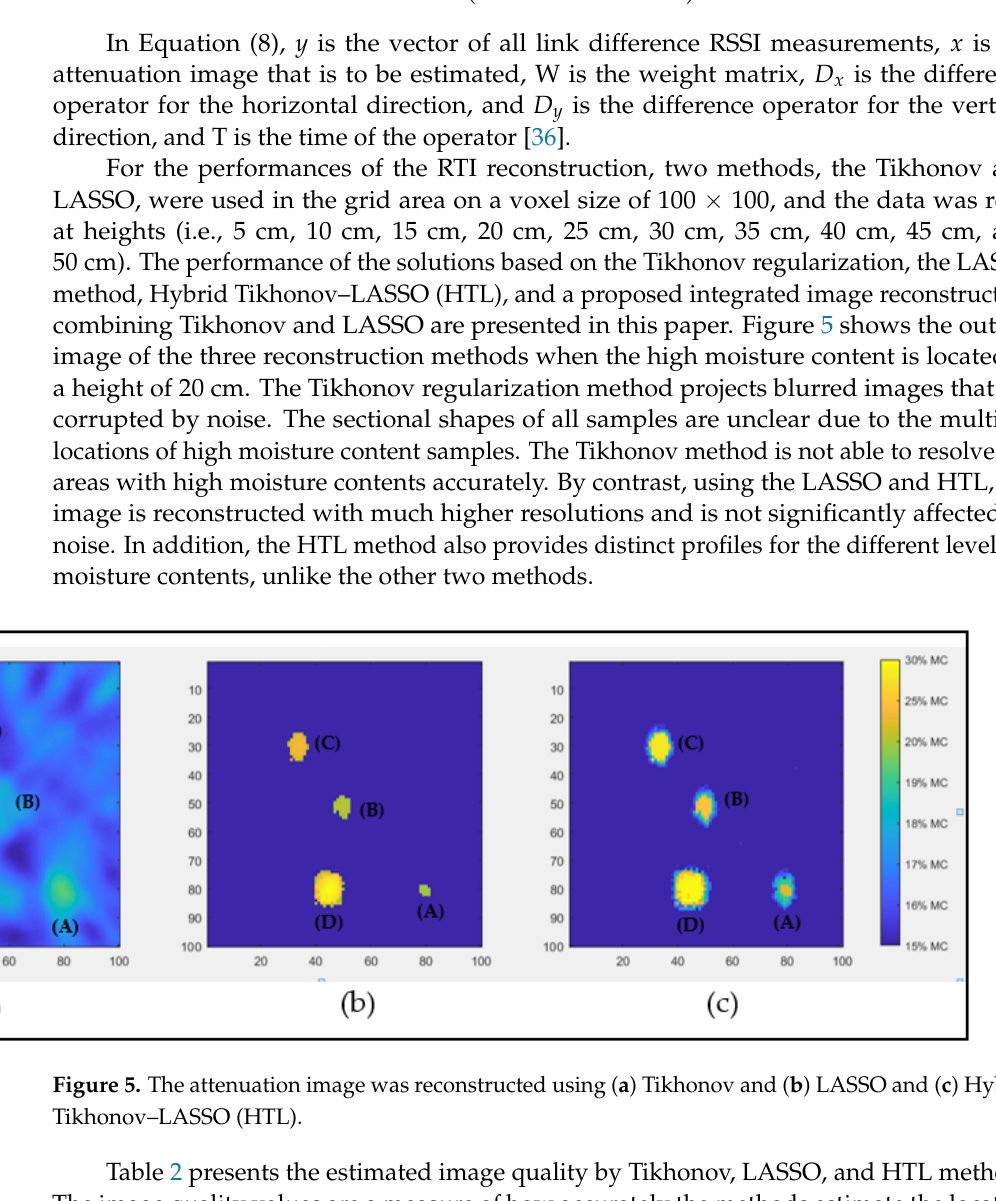
Table 2. Performance evaluation for Tikhonov, LASSO, and HTL.